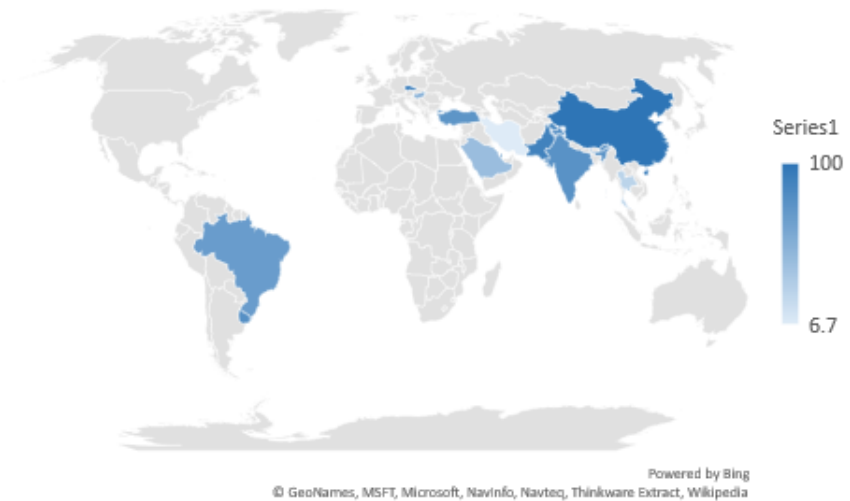
Figure 4: The heat map above shows the prevalence of TTV infection among hepatitis patients across different continent. The data gathered from previous journals are in percentage and the map was constructed by using Microsoft Excel version 2010. The most common type of disease believed to have an association with TTV infection is hepatitis. One of the reason is TTV was first discovered from non-A to non-E hepatitis Japanese patients (Nishizawa et al., 1997). However, the studies conducted hitherto shows collateral with the theory as the percentage of TTV infection among hepatitis patients is in high number in term of infection (majority with more than 50%) throughout the world ( Figure 4 ) (Koohi et al., 2012; Abuodeh et al., 2015; Peng et al., 2015). There are many studies conducted to justify the relationship between TTV infection with hepatitis diseases and many findings showed positive association in term of